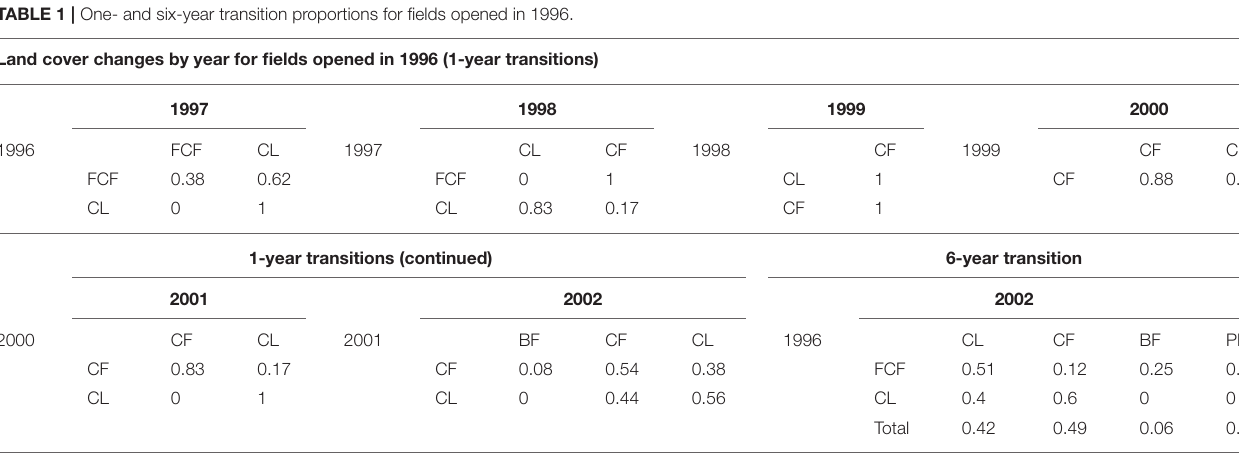
TABLE 1 | One- and six-year transition proportions for fields opened in 1996. Land cover changes by year for fields opened in 1996 (1-year